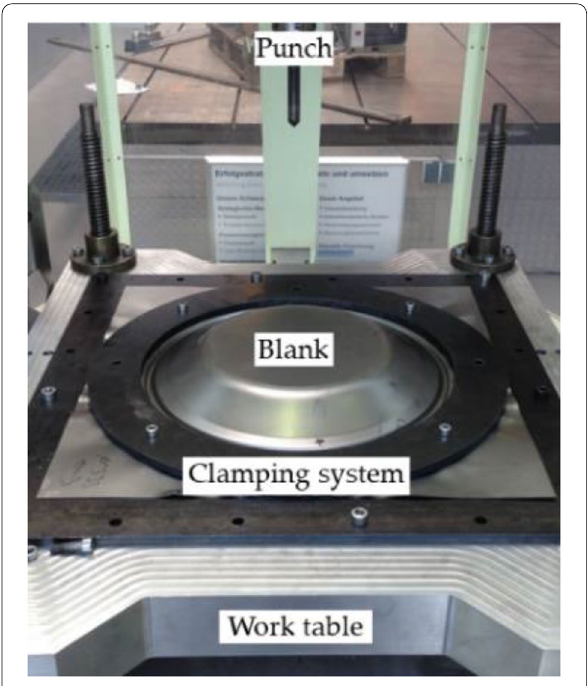
Figure 9 Incremental process